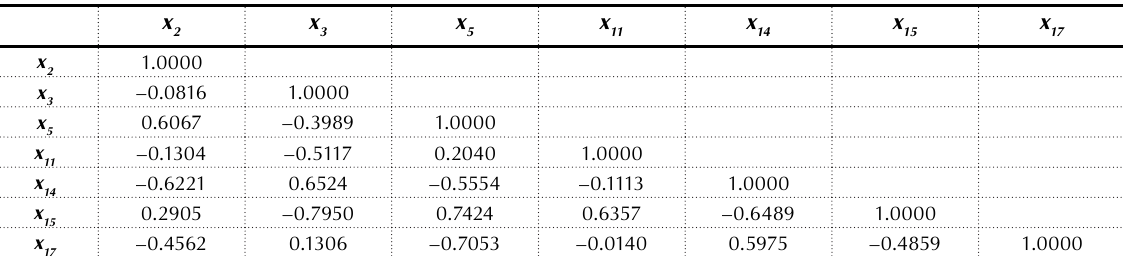
Source: Calculated by the authors.